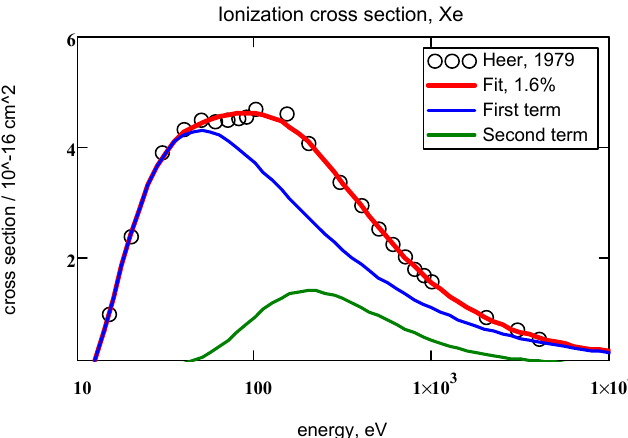
Figure 3. Experiment [18] and the result of approximation by the two − term Formula (7) of the ionization cross section of xenon atoms with a mean square relative error of 1.6%.